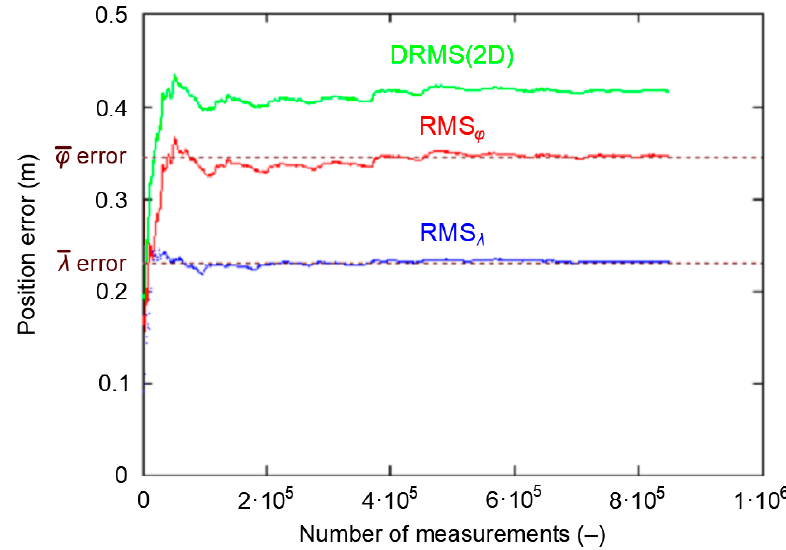
Figure 13. The process of stabilizing RMS values for φ and λ , as well as DRMS(2D) for 864’000 fixes during the DGPS measurement campaign in 2014.